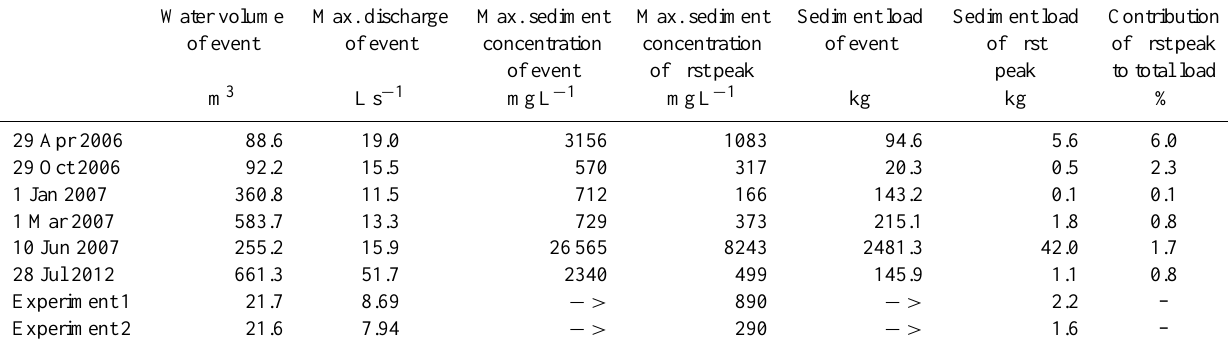
Table 3. Characteristics of natural events and the flooding experiments at the outlet of the HOAL catchment (64ha). The sediment concen- trations and loads of the experiments are listed under first peak as they stem from resuspension.